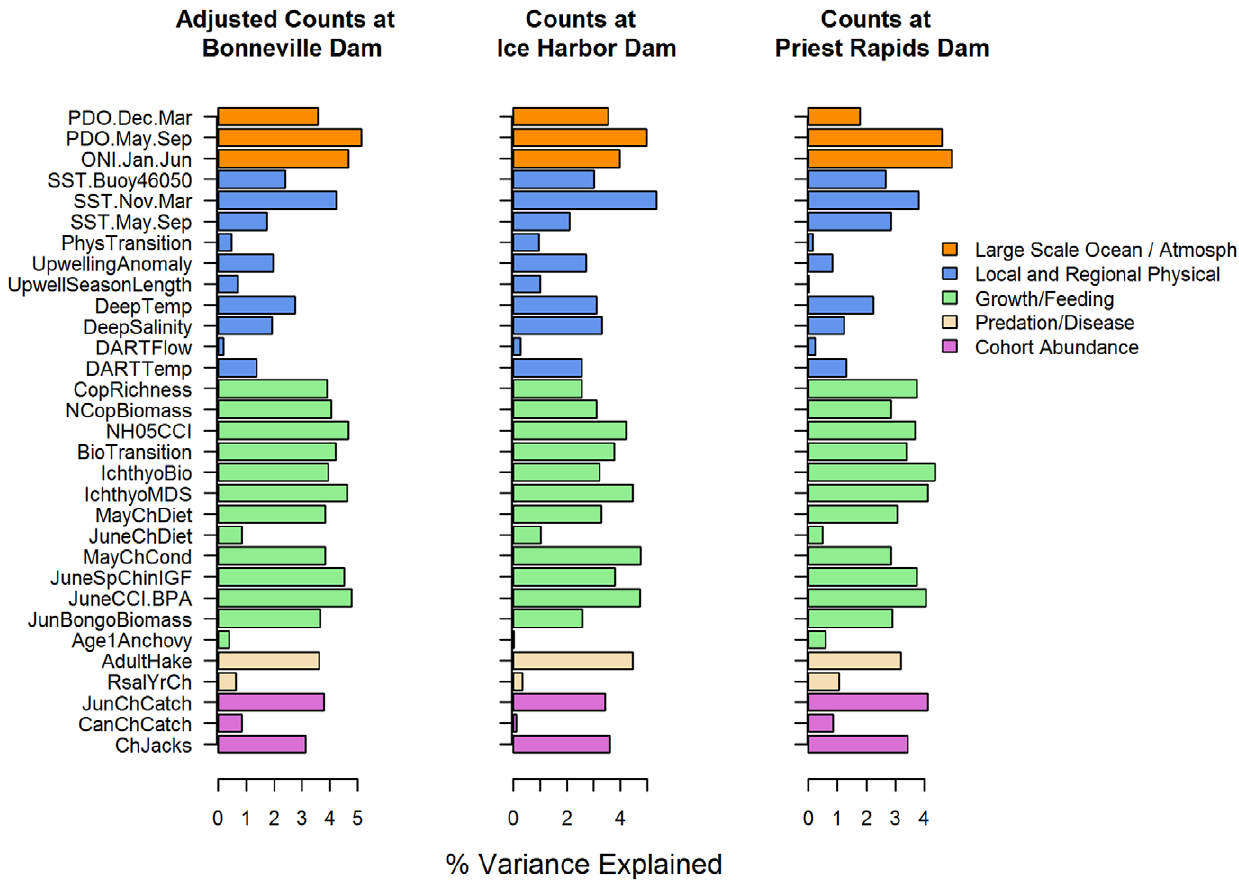
Figure 5. Indicator importance values. Percent of variance in salmon returns explained in the MCA analysis that can be attributed to each indicator (Table 1).